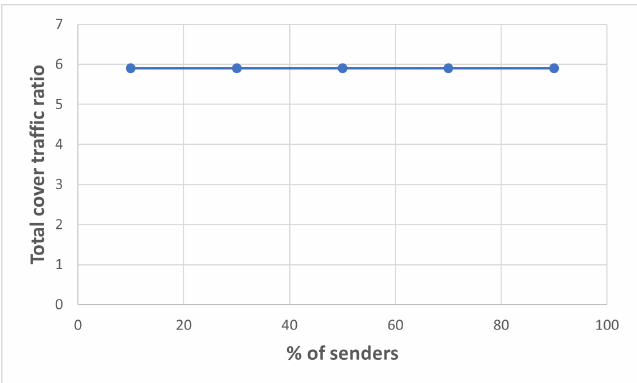
Figure 14. Ratio between the cover traffic of mixnet and Ring2Tor.